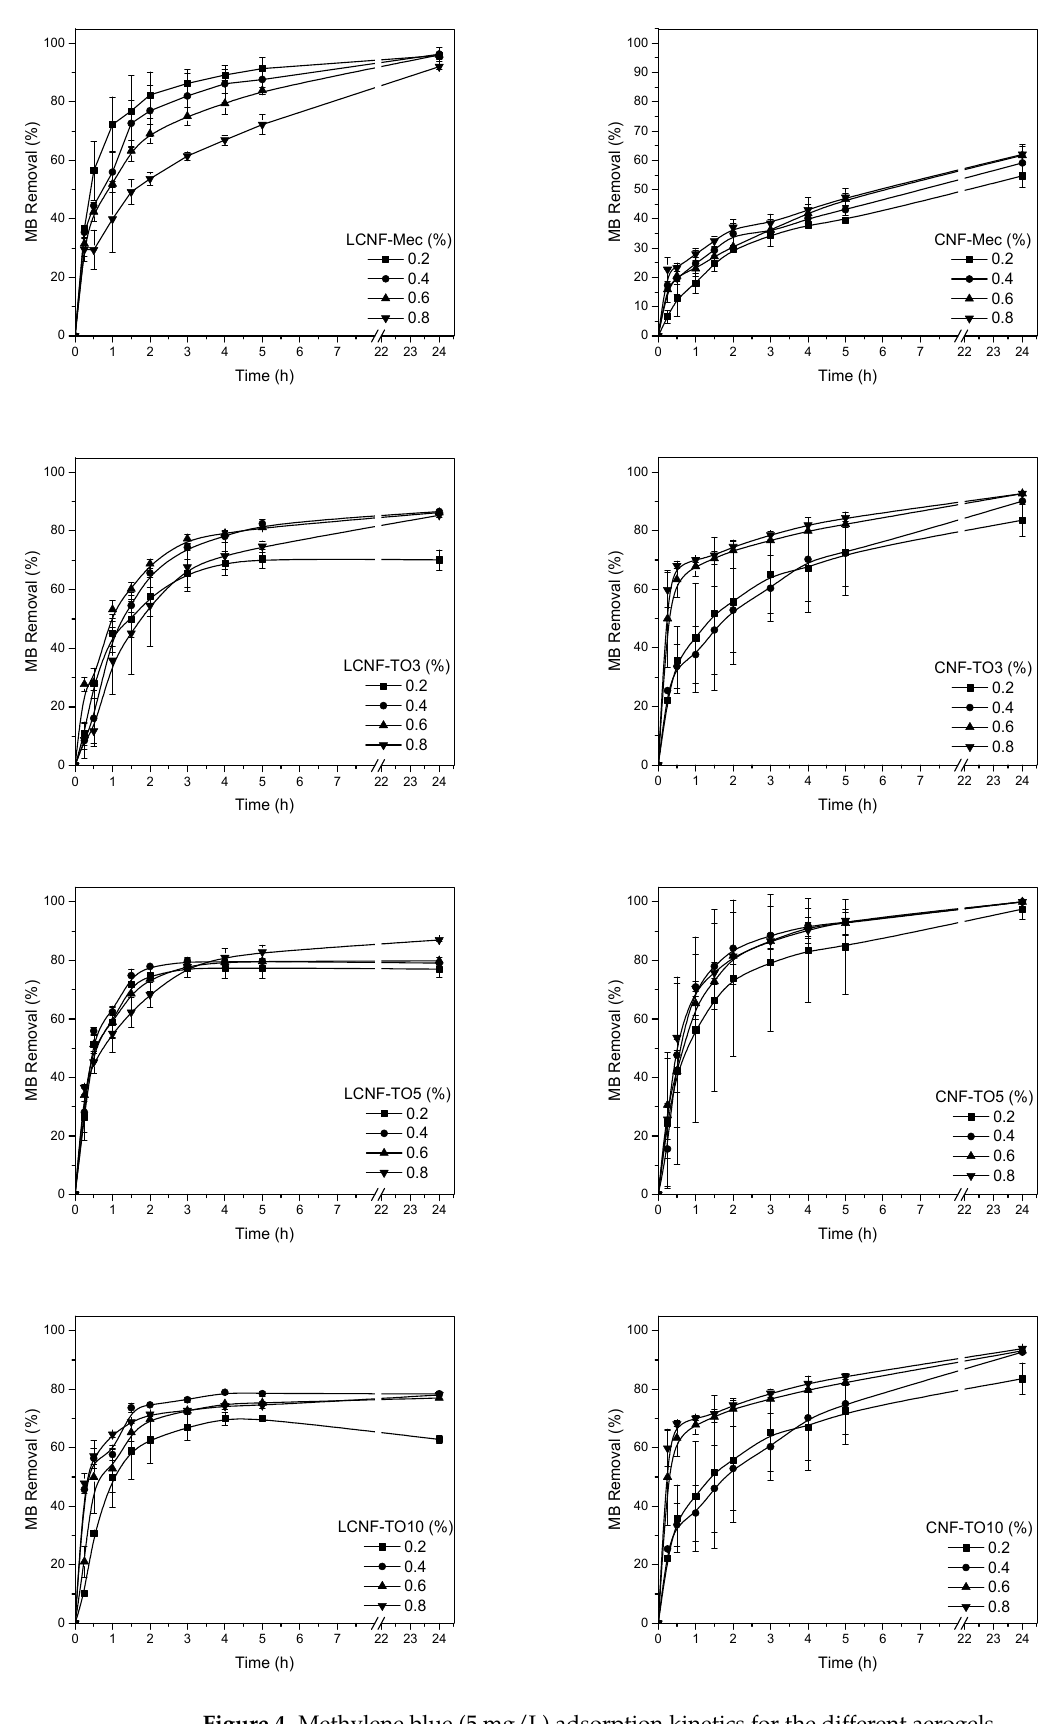
Figure 4. Methylene blue (5 mg/L) adsorption kinetics for the different aerogels.